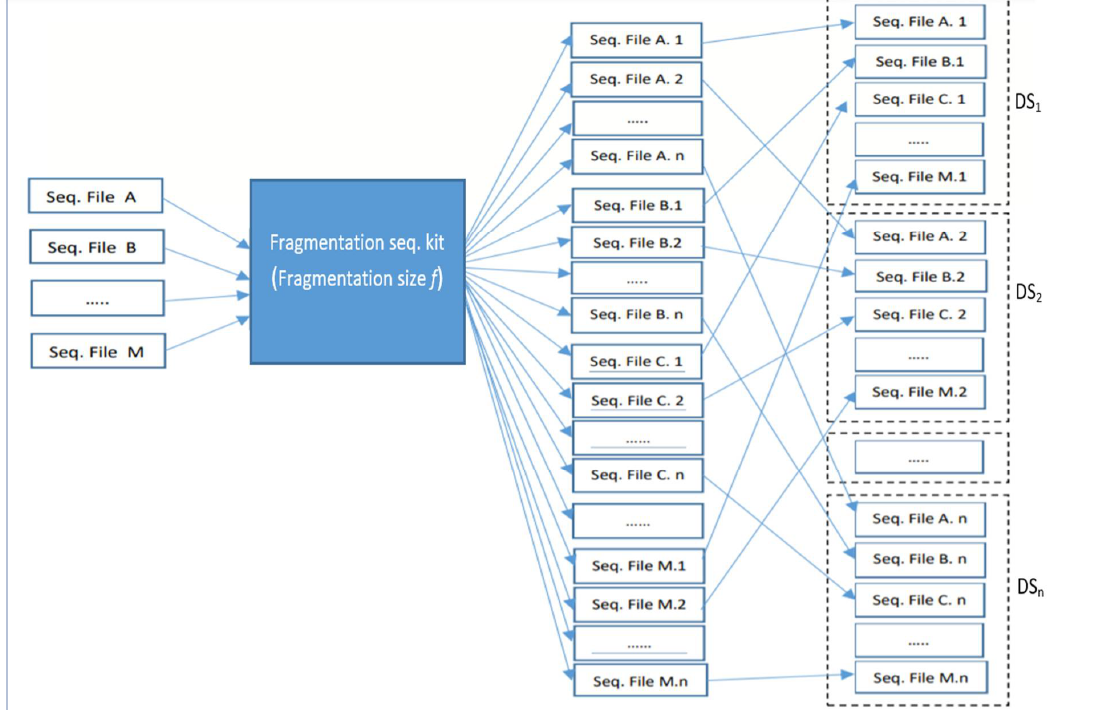
Figure 7. Sequence file fragmentation step of Model_I.